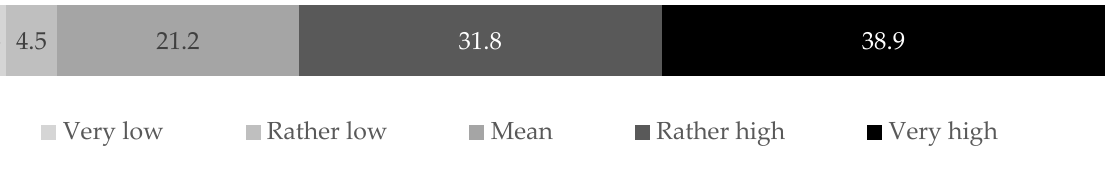
Figure 3. Readiness to change index.